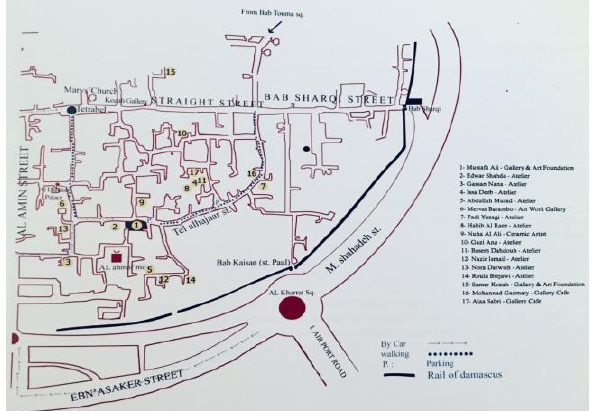
Figure 6. “Seasons of Tell al Hejara” Map, Brochure, 2007.